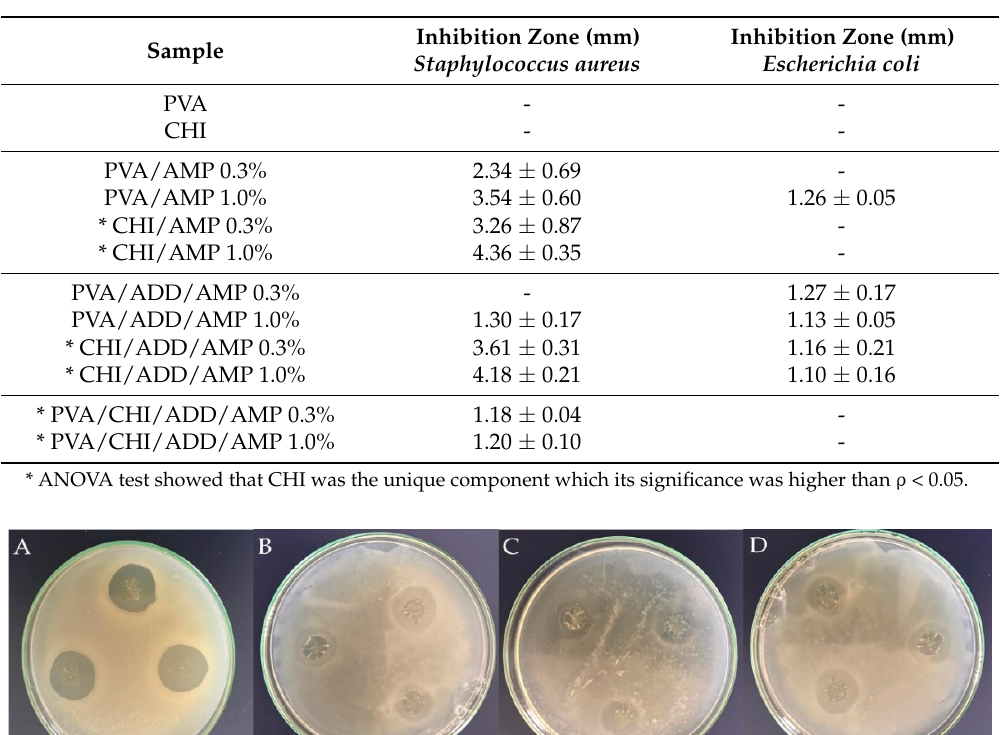
Table 2. Agar diffusion test of the studied sample against Staphylococcus aureus and Escherichia coli.